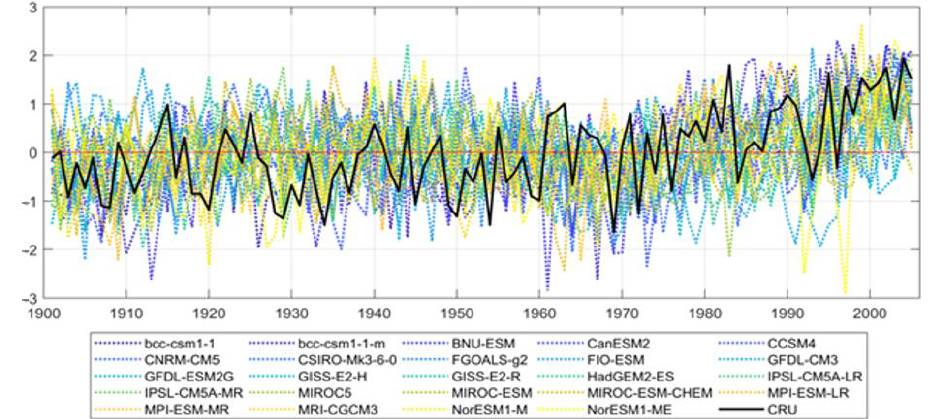
Figure 3. Annual mean SAT anomaly of the observed (CRU) data and 24 CMIP5 climate models, 1901–2005.